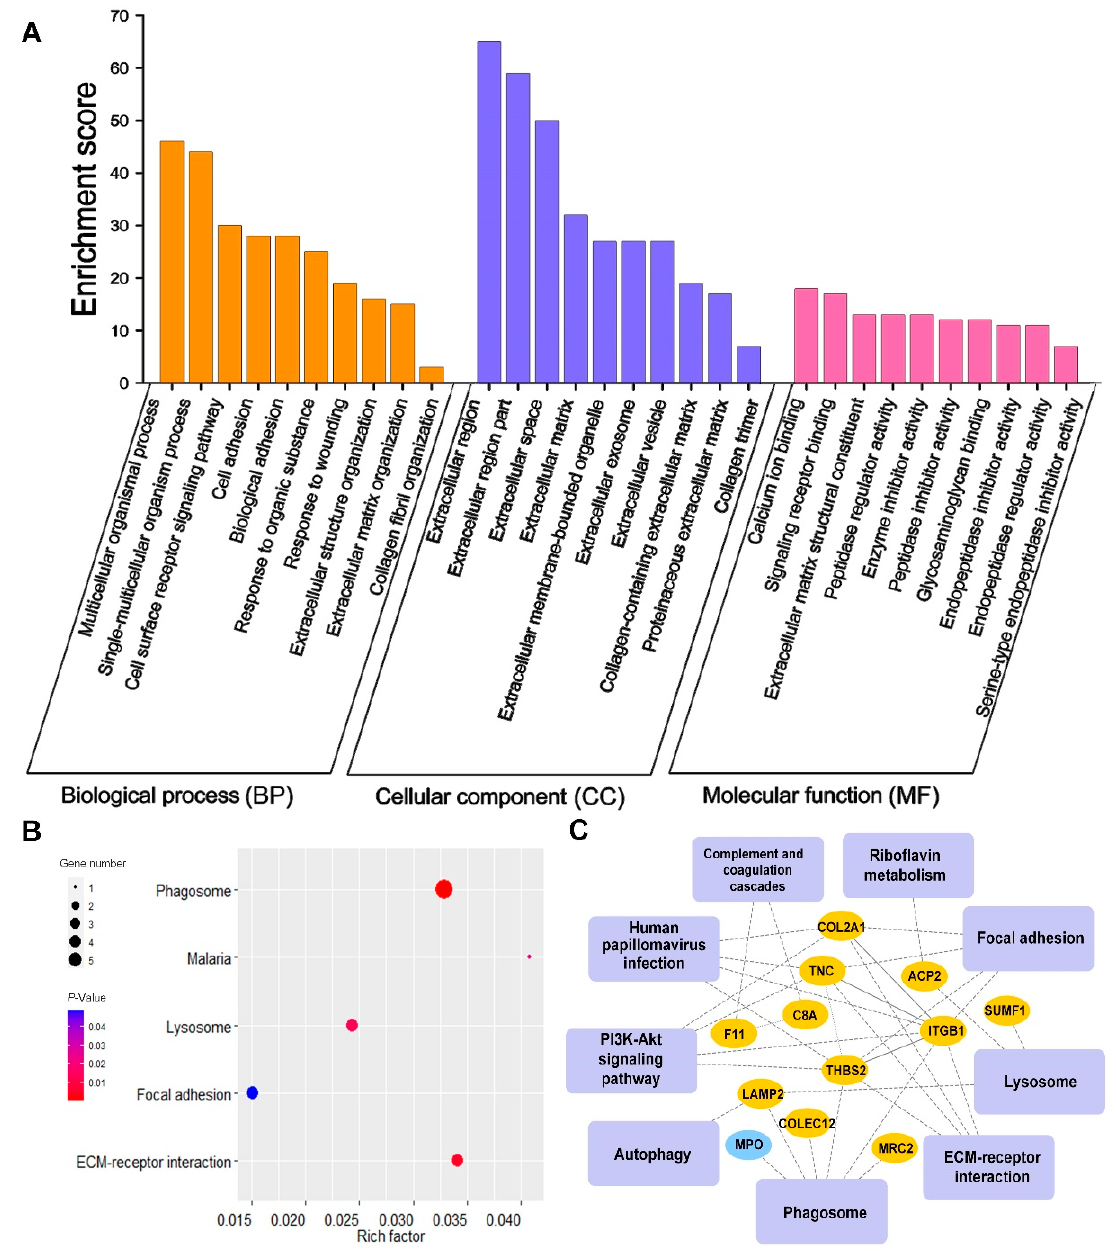
Figure 7. GO, KEGG pathway, and PPI analysis results of differentially expressed N-glycoproteins in OA vs. N ∩ KBD vs. N. ( A ) GO analysis of the differentially expressed N-glycoproteins of cartilage in OA vs. N ∩ KBD vs. N. ( B ) Bubble diagram of KEGG pathways in OA vs. N ∩ KBD vs. N. The blue to red gradient of bubbles of KEGG pathways represents the significance from low to high, respectively. Bubble size represents the number of differentially expressed N-glycoproteins in the KEGG pathway. ( C ) PPI network commonly shared between OA vs. N and KBD vs. N. Rectangles represent KEGG pathways, and circles represent N-glycoproteins. Solid lines mean the relationship has been verified by research, dashed lines mean the relationship have not been verified. The yellow and blue colors of the N-glycoproteins represent up-regulated and down-regulated, respectively.